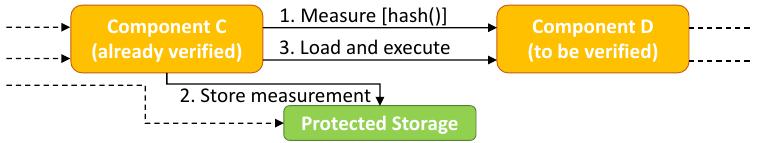
Figure 3. Basic element of a Chain of